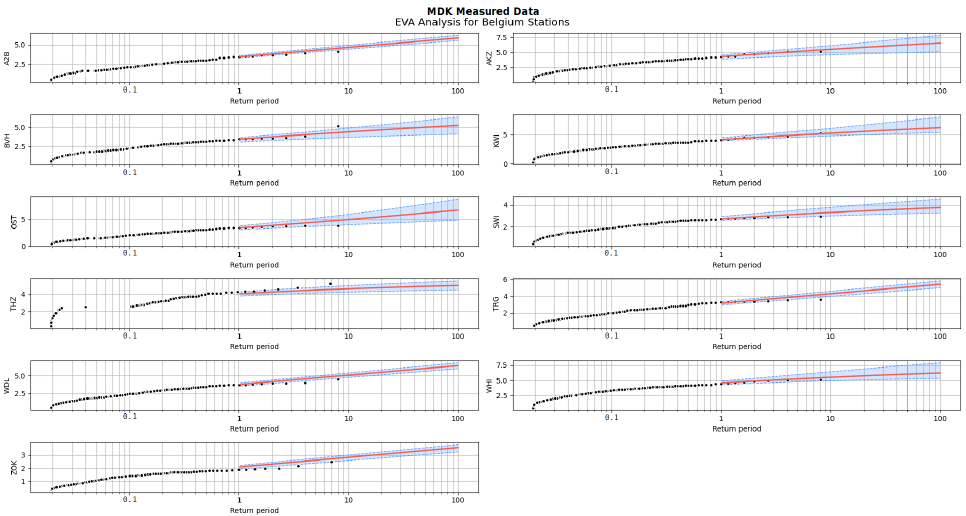
Figure 13. Linearised General Extreme Value Analysis plots for calculated significant wave height vs. return period (years) for measured significant wave heights at various Belgian stations.